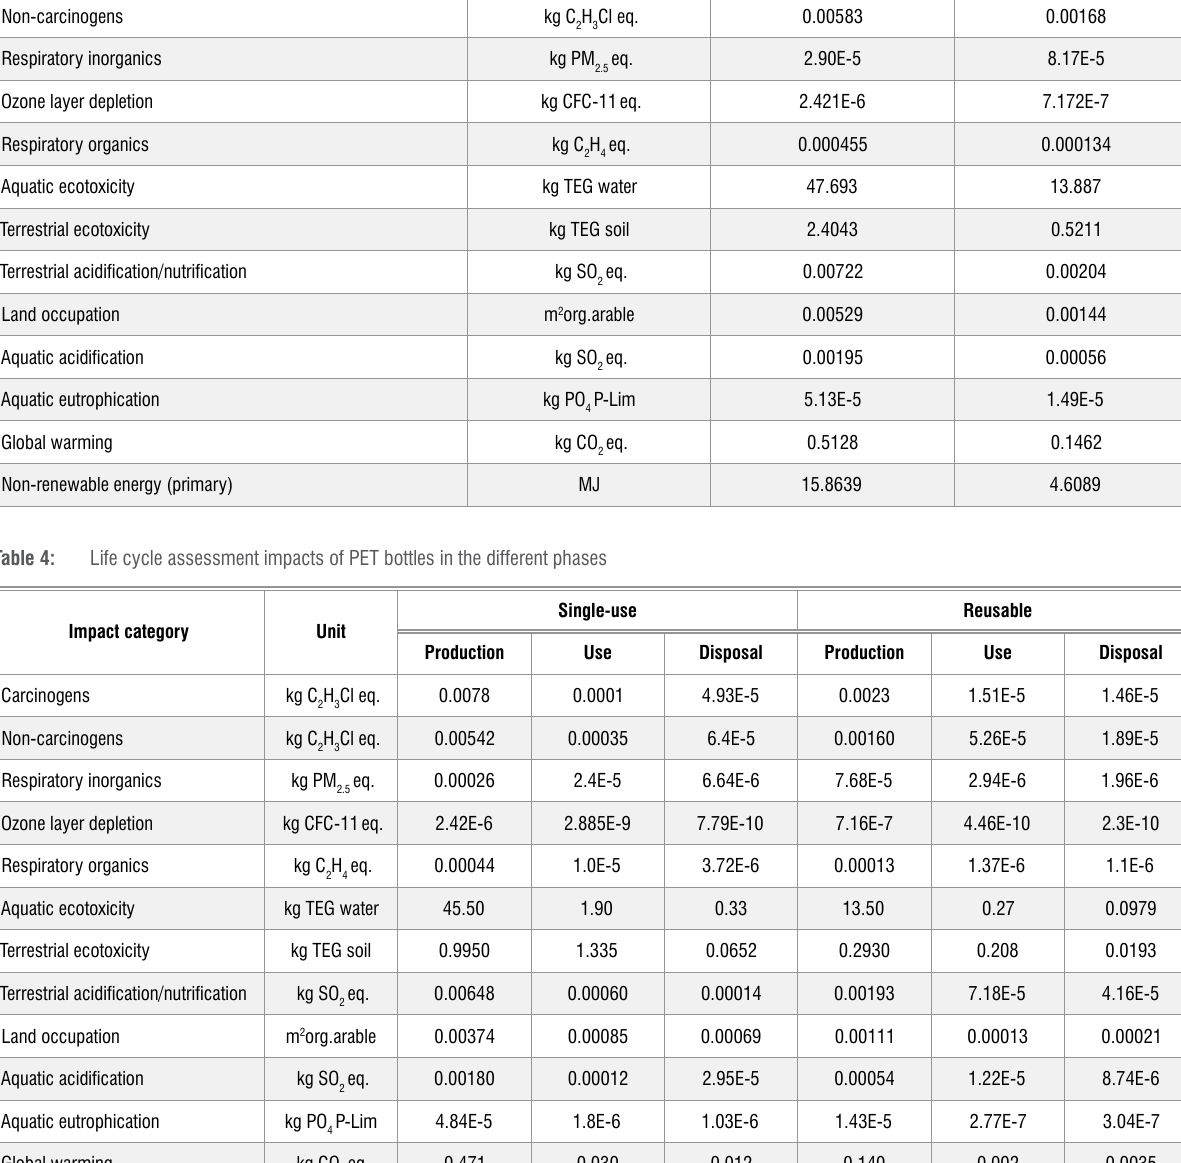
Total life cycle assessment impacts of PET bottles